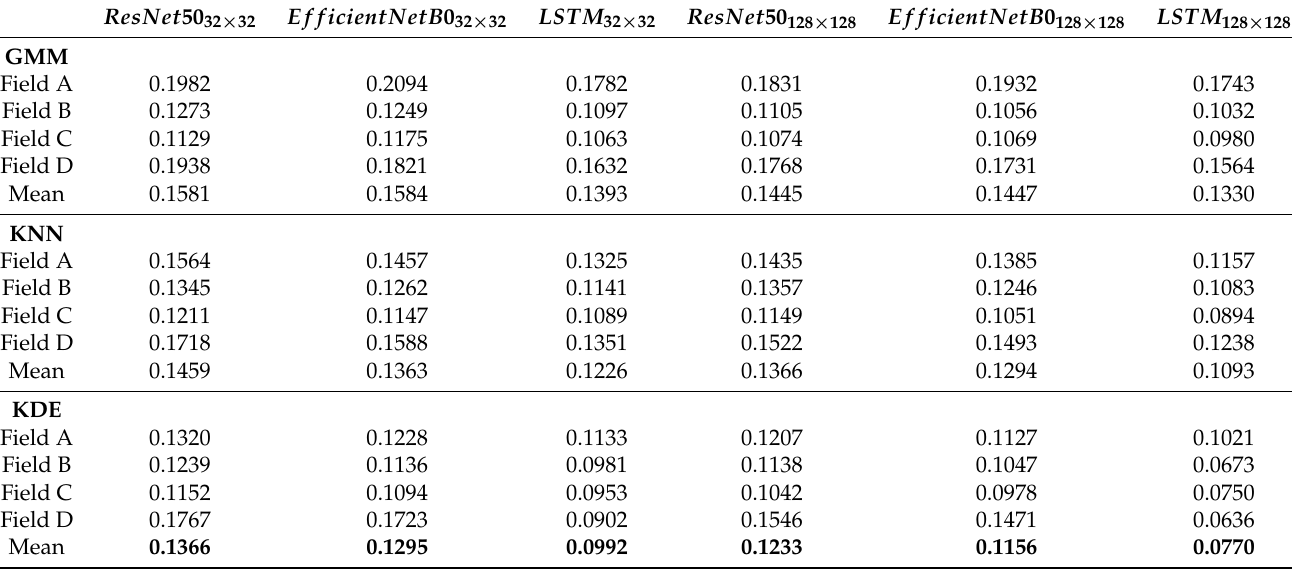
Table 8. RMSE for each neural network and labeling models with varying sizes of the input images (32 × 32 pixels on the left side and 128 × 128 pixels on the right side of the